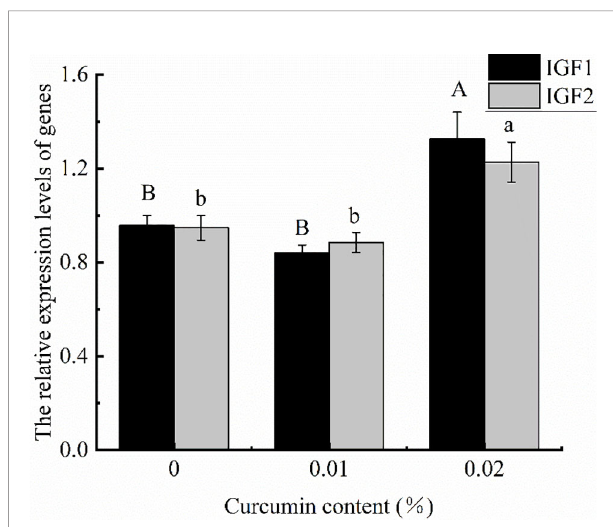
FIGURE 4 | Effects of different levels of curcumin on the quantitative expression of IGF1 and IGF2 genes in the liver of Seriola dumerili . Different uppercase or lowercase letters indicate signi fi cant differences between treatments (p <